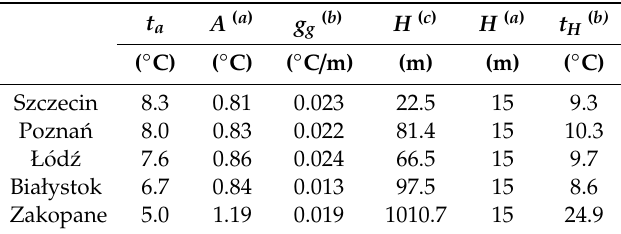
Table 4. The groundwater basins